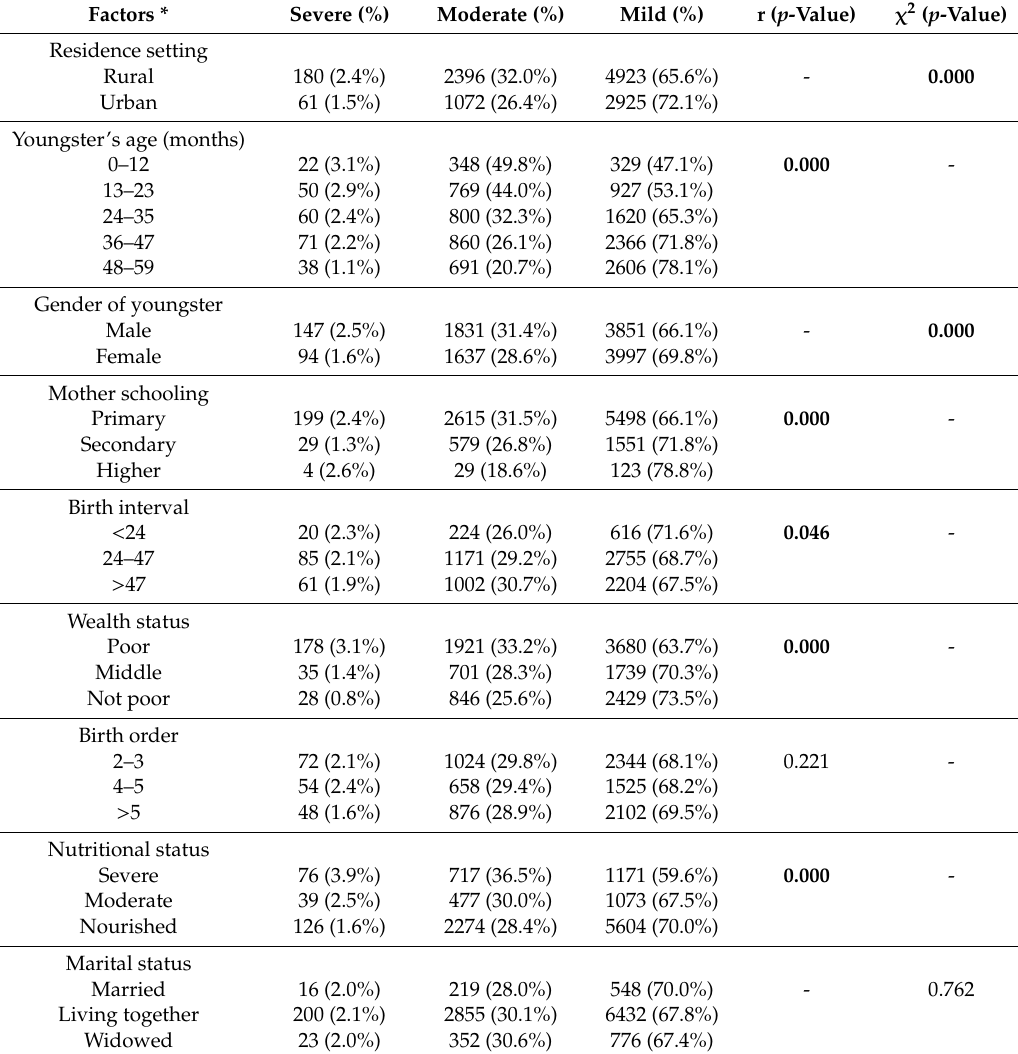
Table3. Assessingtheassociationbetweenselectedcovariateandanemiastatusofunder-fiveyoungsters using the gamma and chi-square test, pooled